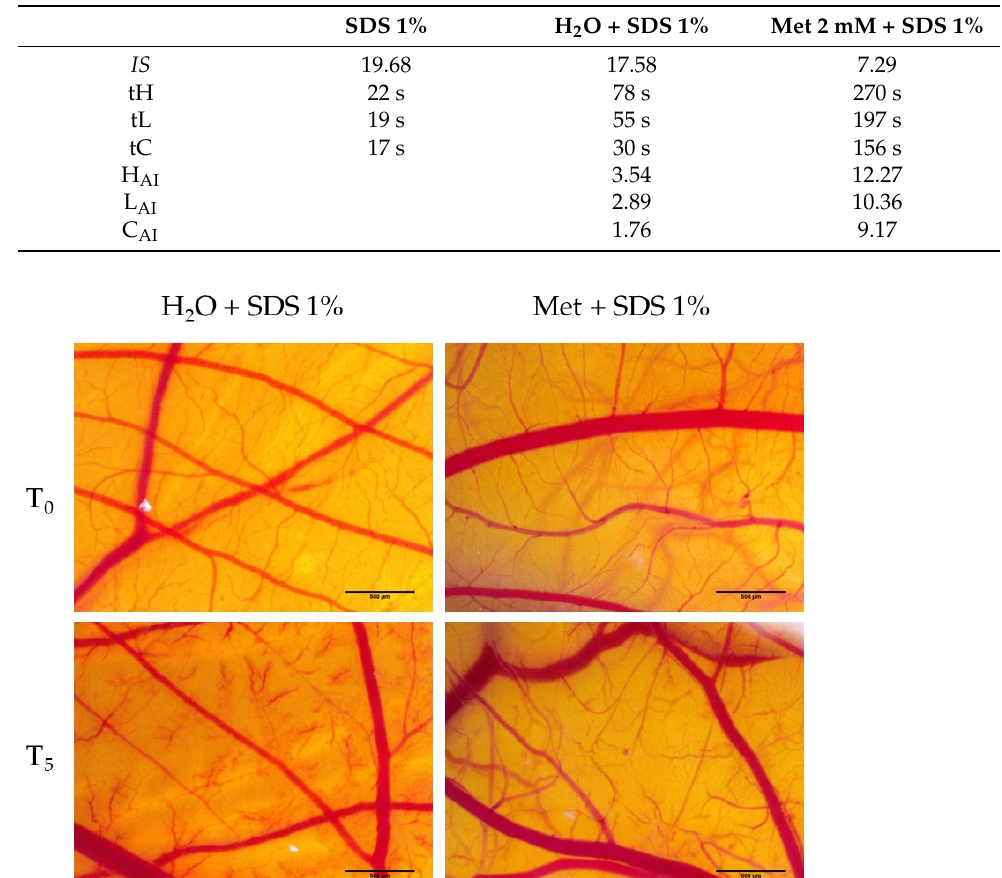
Table 2. Anti-irritant effects of Met at a concentration of 2 mM and solvent H 2 O after CAM irritation with SDS 1%.